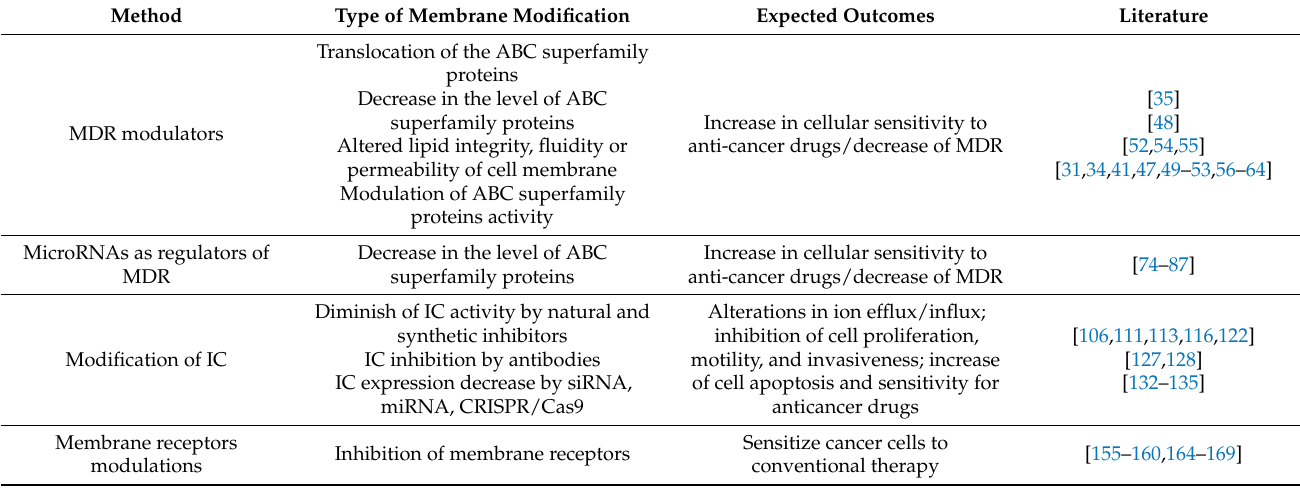
Table 1. Types of plasma membrane modification for targeted cancer